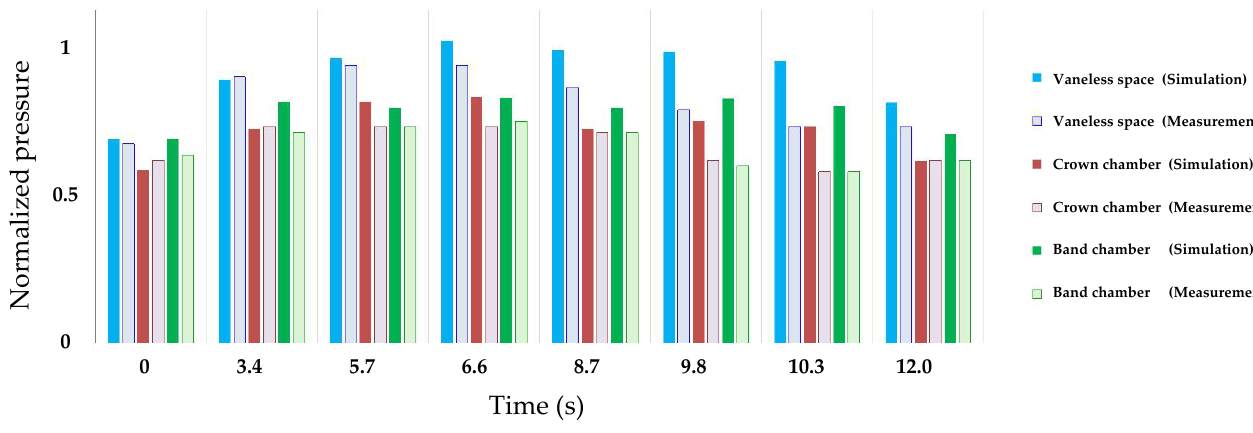
Figure 8. Comparison of the measured and simulated pressure results during load rejection. Most of the deviations between the simulation and measurement are in the range of 0.3–13%, and the largest deviation is around 27%. The following factors can